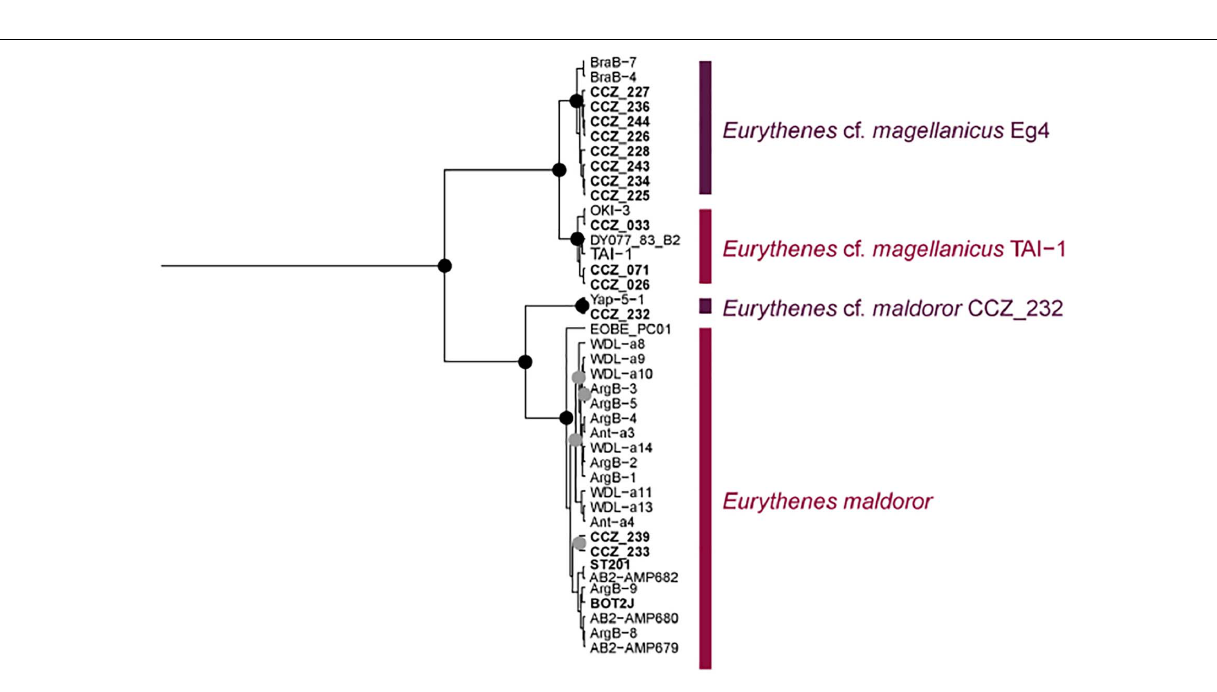
TABLE 3 | Population genetic statistics for six genetic species of scavenging amphipods occurring in the western CCZ. Species No. samples S h π AMOVA